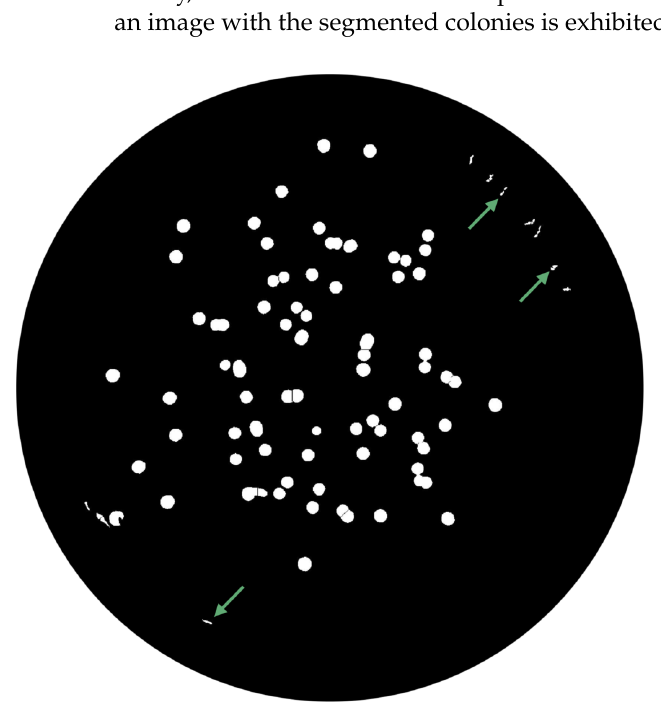
Figure 17. Segmented colonies by watershed